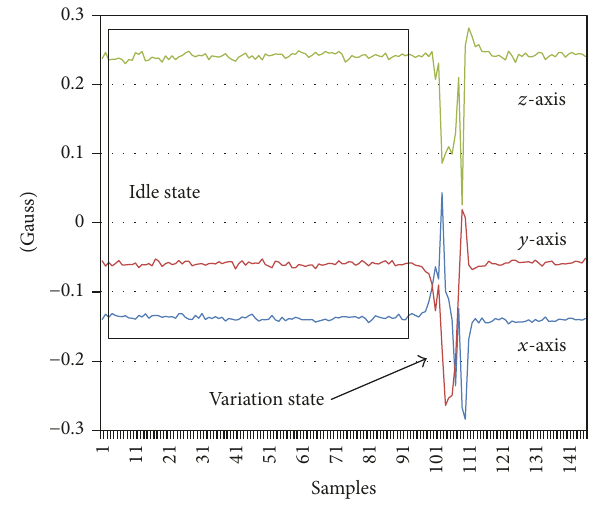
Figure 10: Detection of a vehicle by the magnetic sensor. The idle state and variation state are caused by the penetration of a car in the magnetic field. The Gauss measurements taken by the sensor are shown on the 𝑦 -axis while the temporary samples are observed on the 𝑥 -axis.